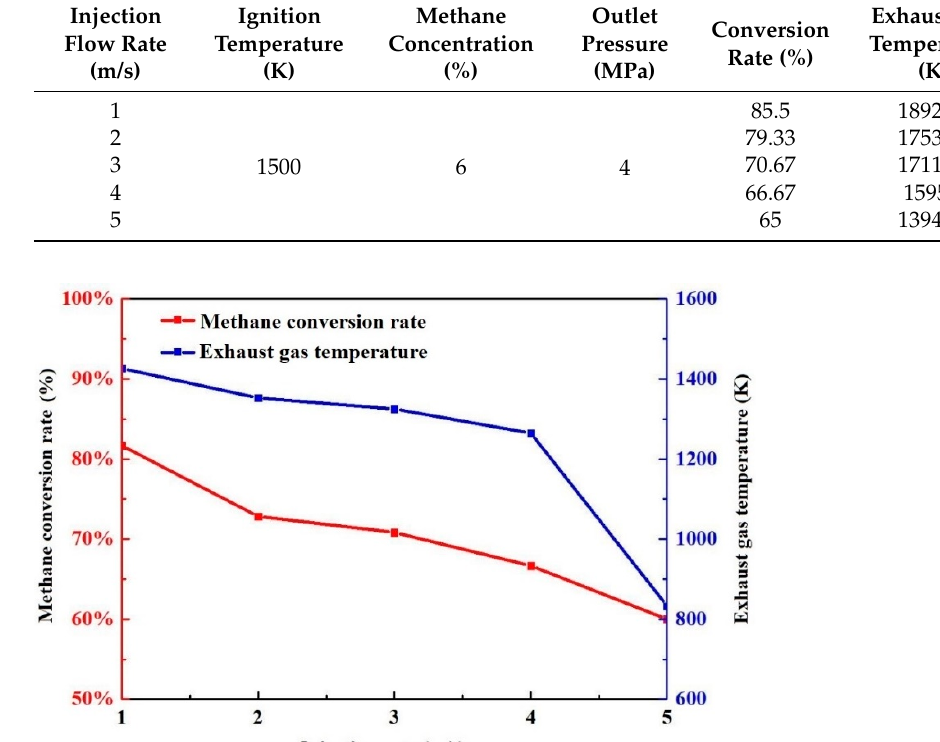
Figure 15. The influence of injection rate on conversion rate and exhaust gas temperature at 2 MPa.